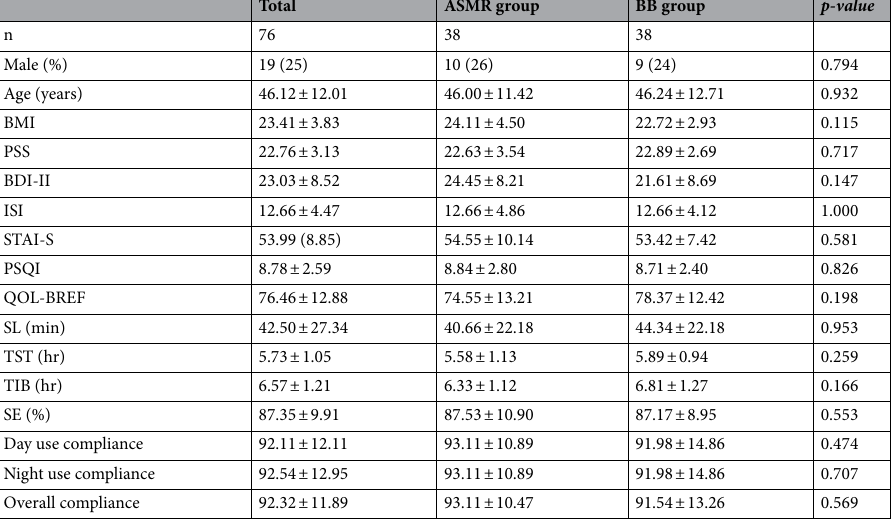
Table 1. Demographic characteristics of participants (N = 76). Data represent N (%) for sex and mean ± standard deviation for others. The independent t-test or Mann–Whitney U test was performed for numerical variables and the chi-squared test was performed for categorical variables. PSS : Perceived stress scale, BDI-II : Beck depression inventory II, ISI : Insomnia severity index, STAI-S : State-trait anxiety inventory- state anxiety, PSQI : Pittsburgh Sleep Quality Index, QOL-BREF : Quality of Life scale abbreviated version, SL : Sleep latency, TST : Total sleep time, TIB : Time in bed, SE : Sleep efficiency, ASMR : Autonomous sensory meridian response, BB : Binaural beat.